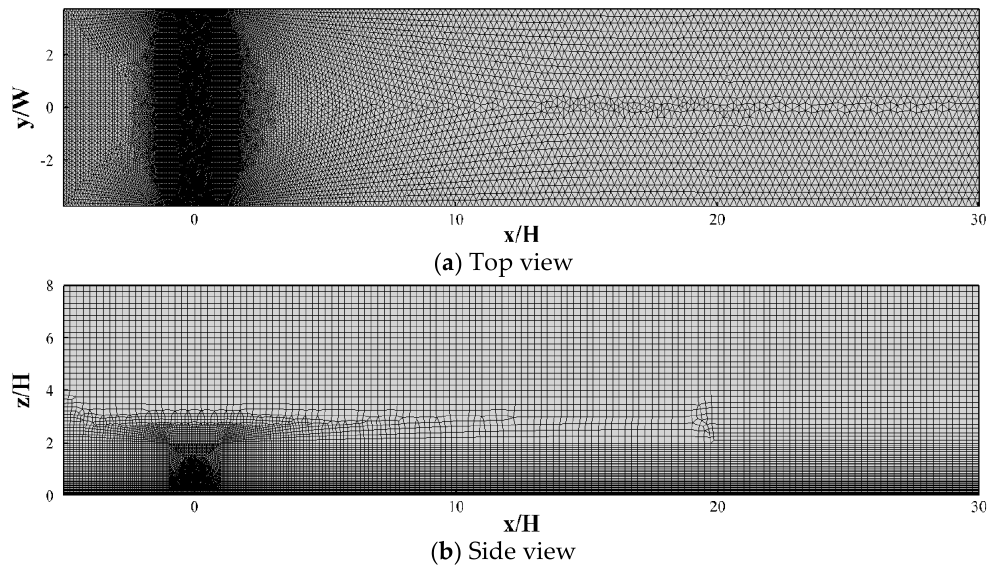
Figure 9. Computational domain and grid system (H = 6 m, S/W = 1.5).